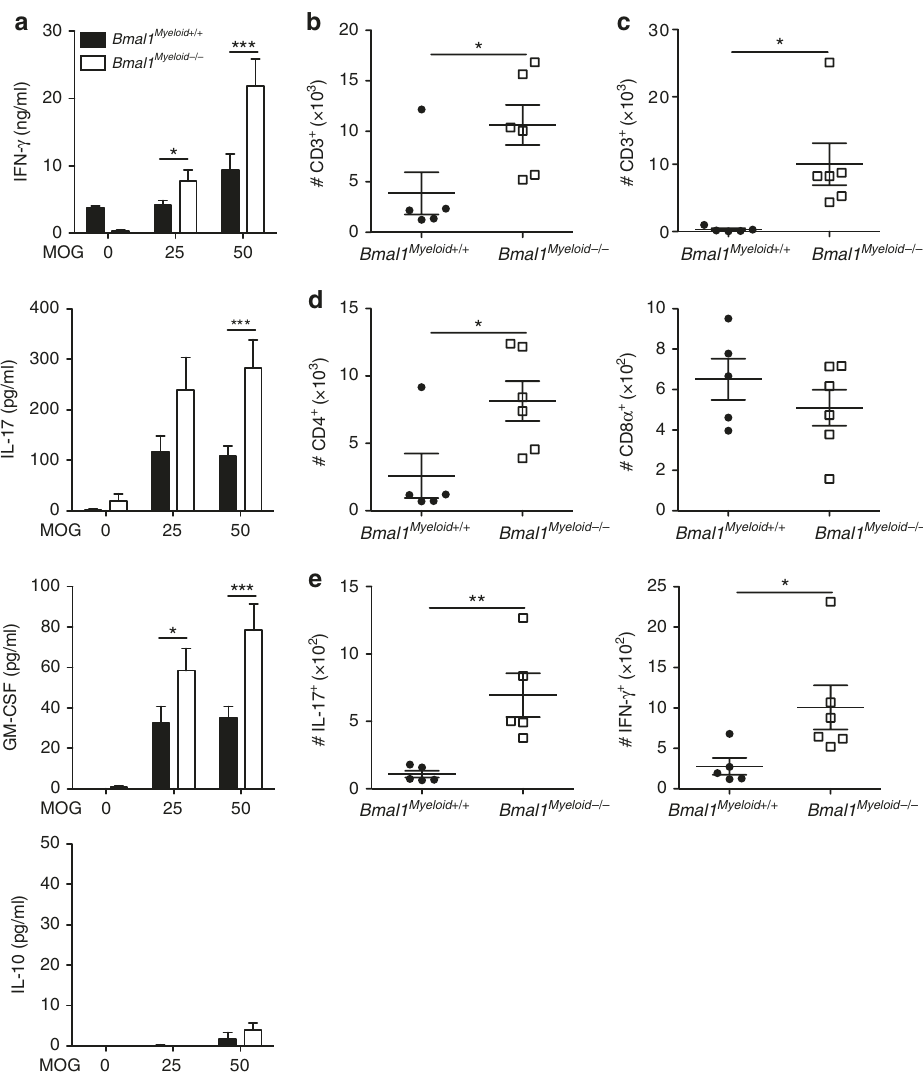
Fig. 4 Enhanced Th1 and Th17 responses in the CNS of Bmal1 Mye − / − mice with EAE. a – e Bmal1 Myeloid + / + or Bmal1 Myeloid − / − mice were immunized with myelin oligodendrocyte glycoprotein (MOG 35 – 55 ) + complete Freund ’ s adjuvant (CFA) on d 0 and with pertussis toxin (PT) (125 ng/mouse) on d 0 and d 2. a After 14 d draining lymph node (LN) cells were re-stimulated in the presence and absence of MOG 35 – 55 antigen (25 and 50 µ g/ml) or with medium for 72 h. Supernatants were removed and tested for IL-17, GM-CSF, IFN- γ and IL-10. Statistics by one way ANOVA with Tukey ’ s post-test of triplicate assay of 6 mice per group. b – e 10 d post immunization brain and spinal cords were isolated and surface stained for CD45, CD3, CD8 α and CD4 and intracellularly for IL-17 and IFN- γ . b Cells were gated on live CD45 + cells in the brain ( n = 5 – 6). c Cells were gated on live CD45 + cells spinal cord ( n = 5 – 6). d Cells were gated on live CD45 + CD3 + cells in the brain ( n = 5 – 6). e Cells were gated on live CD45 + cells in the brain ( n = 5 – 6). Statistics were performed by Mann – Whitney U test ( b – e ). All data presented as means ± standard error of the mean (SEM). * p < 0.05; ** p < 0.01; *** p <